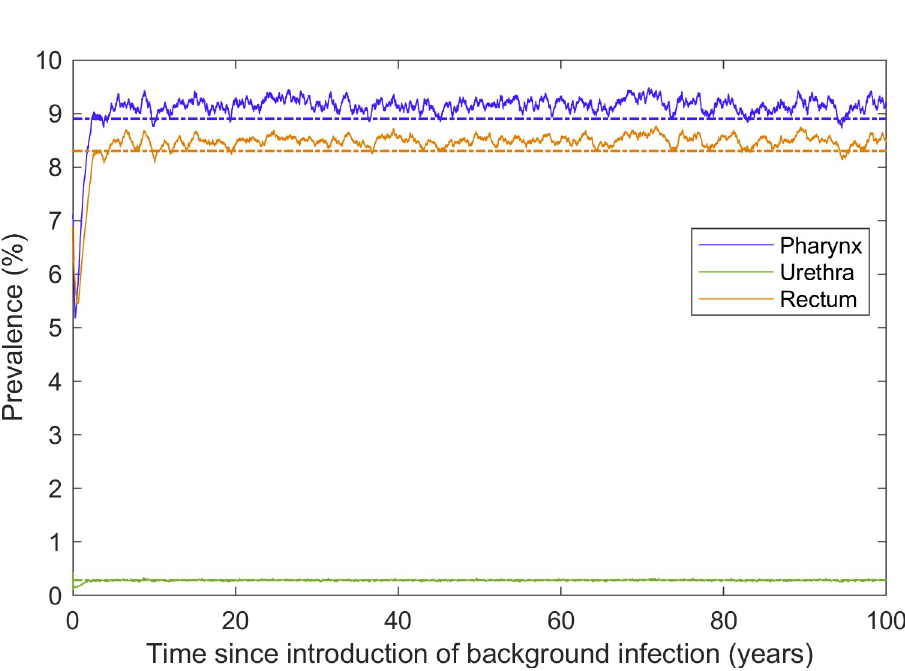
Fig 2. Average daily model-generated site-specific prevalence over 50 simulations (solid lines) and calibration targets (dashed lines). Each simulation was run for 100 years using the per-act transmission probabilities obtained through the calibration process and daily site-specific prevalence was averaged over the 50